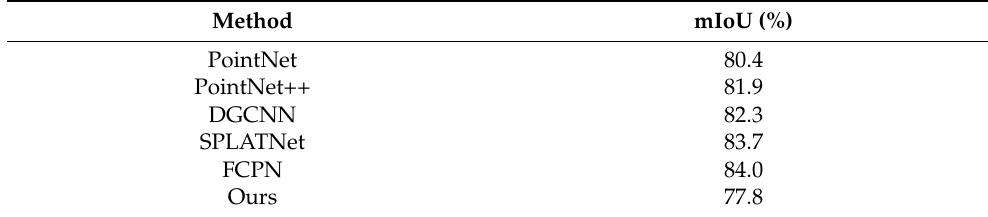
Table 4. The segmentation results of the model and the supervised learning